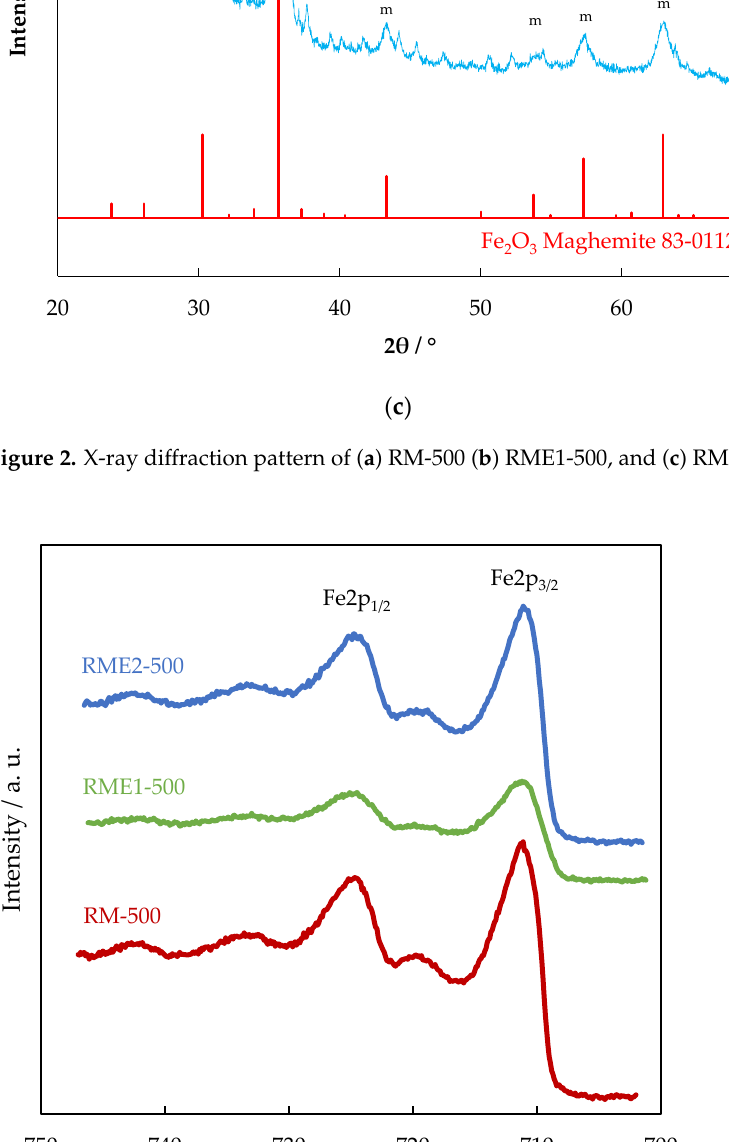
Figure 3. High-resolution Fe2p XPS spectra for the RM and RME samples.